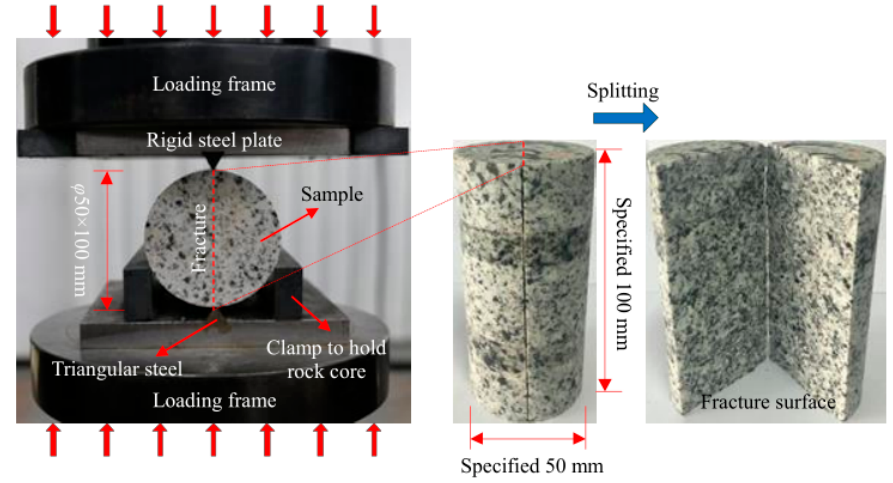
Figure 2. Preparation of rough-walled rock fractures using tensile splitting of an intact cylindrical sample.